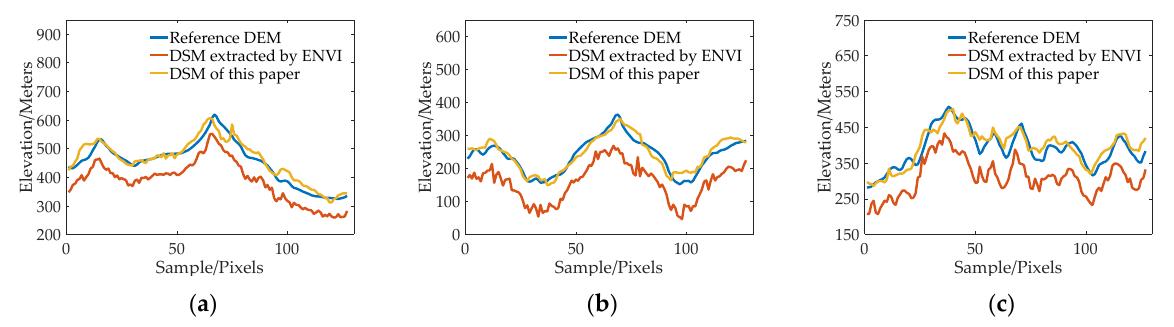
Figure 12. The elevation profiles comparison of three ridge regions: ( a ) Region 1; ( b ) Region 2; ( c ) and Region 3.